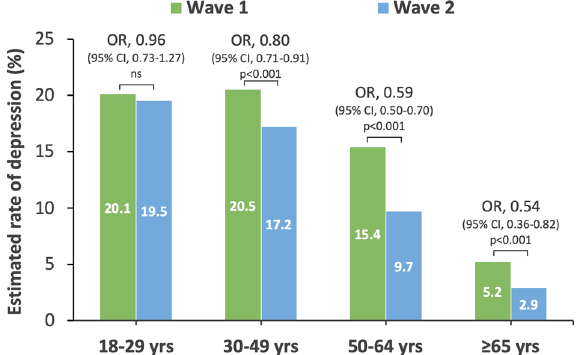
Figure 2. Estimated rate of depression for each age group in wave 1–2. CI confidence interval, OR odds ratio.